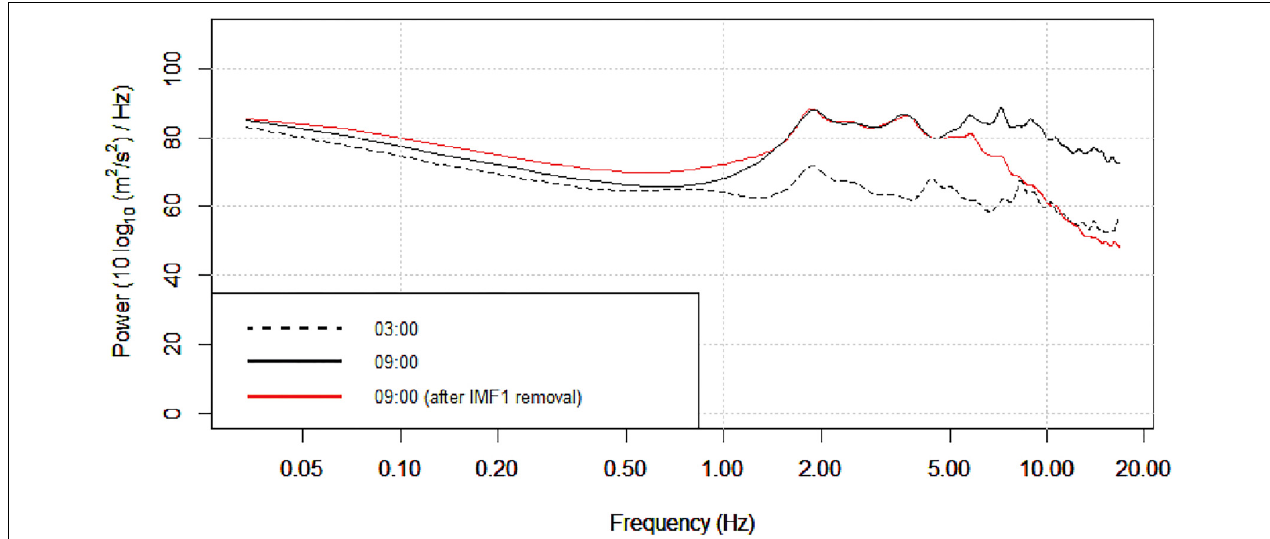
FIGURE 6 | Results of transient noise removal. Dashed and solid black lines represent the frequency spectrum at a quiet and busy time, respectively. The red line represents the frequency spectrum at a busy time after the removal of transient noise.